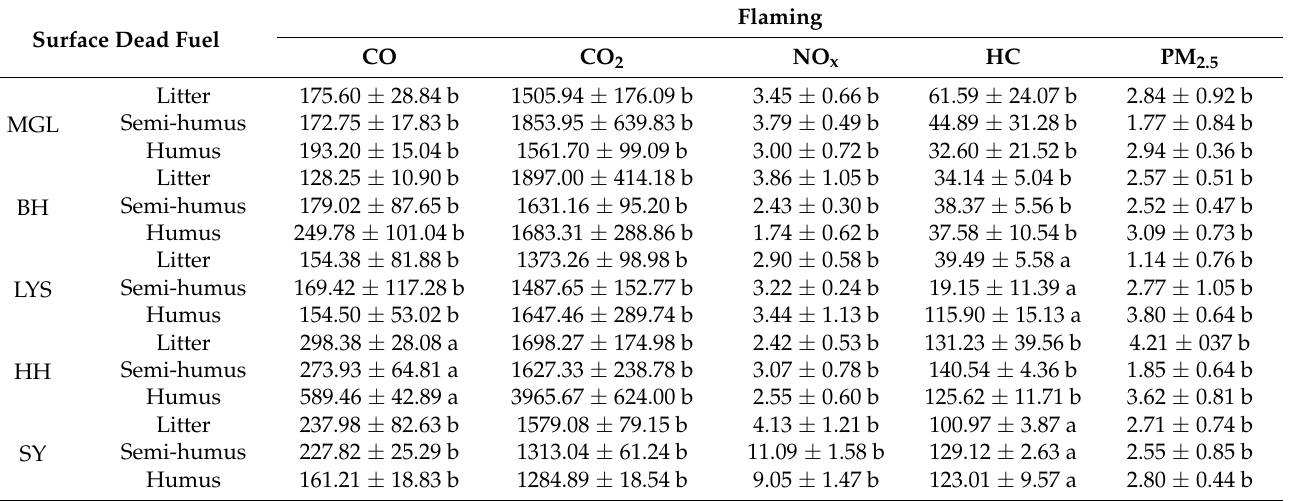
Figure 4. Emissions released by three shrub species under different combustion states. Note: XADJ, Rhododendron dauricum L.; HZZ, Lespedeza bicolor Turcz ; PZ, Corylus heterophylla Fisch ; Identical letters indicate no significant difference, while different letters indicate a significant difference between the treatment and the control;the same below. Table 2. Emissions of different surface dead fuel layers under different combustion states (mean ± standard deviation;